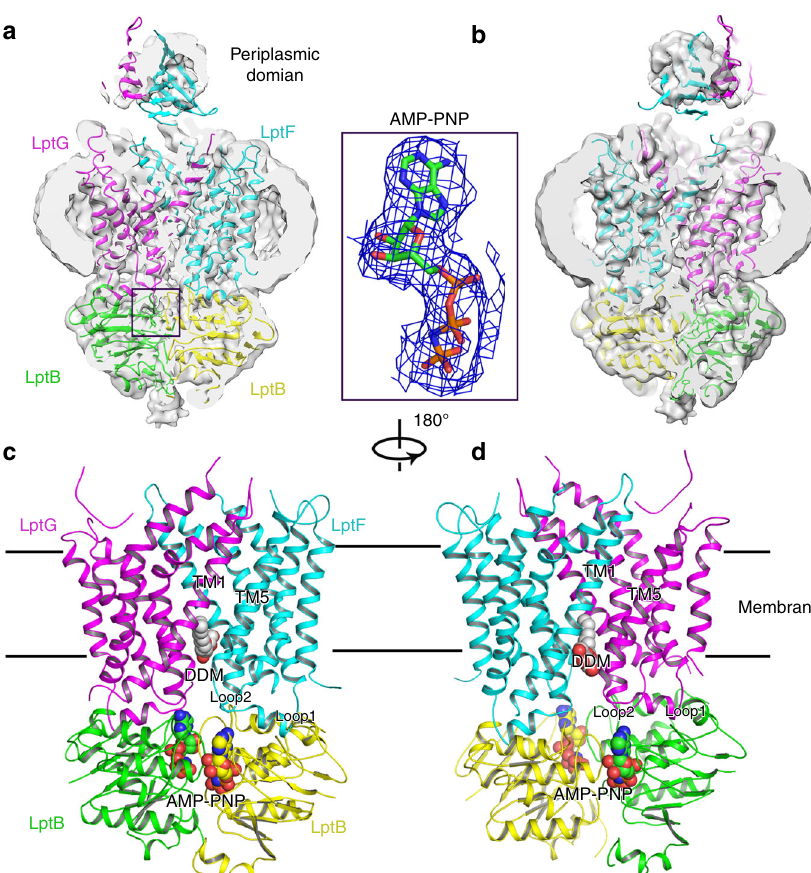
Fig. 4 Structure of AMP-PNP-bound sf LptB 2 FGC. a Cryo-EM map of AMP-PNP-bound sf LptB 2 FGC. The LptC density is not observed. Density of AMP-PNP is shown in blue mesh and AMP-PNP is shown in stick. The colour scheme is the same as Fig. 1. b Rotation of 180° along the y -axis relative to a . c Cartoon representation of AMP-PNP-bound sf LptB 2 FGC. AMP-PNP is shown in spheres with carbon colour in green or yellow. DDM is shown in sphere with carbon in grey. d Rotation of 180° along y -axis relative to c . The DDM molecule is trapped in the lateral gate